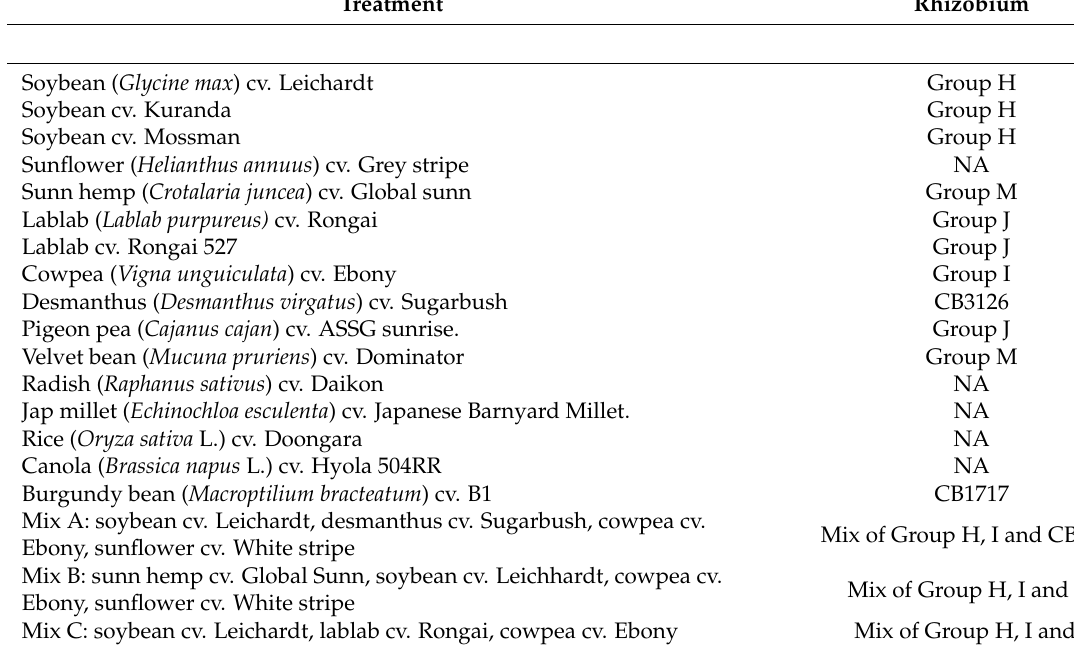
Table 2. Cover crop treatments and seeding rates in trial 1 and trial 2.